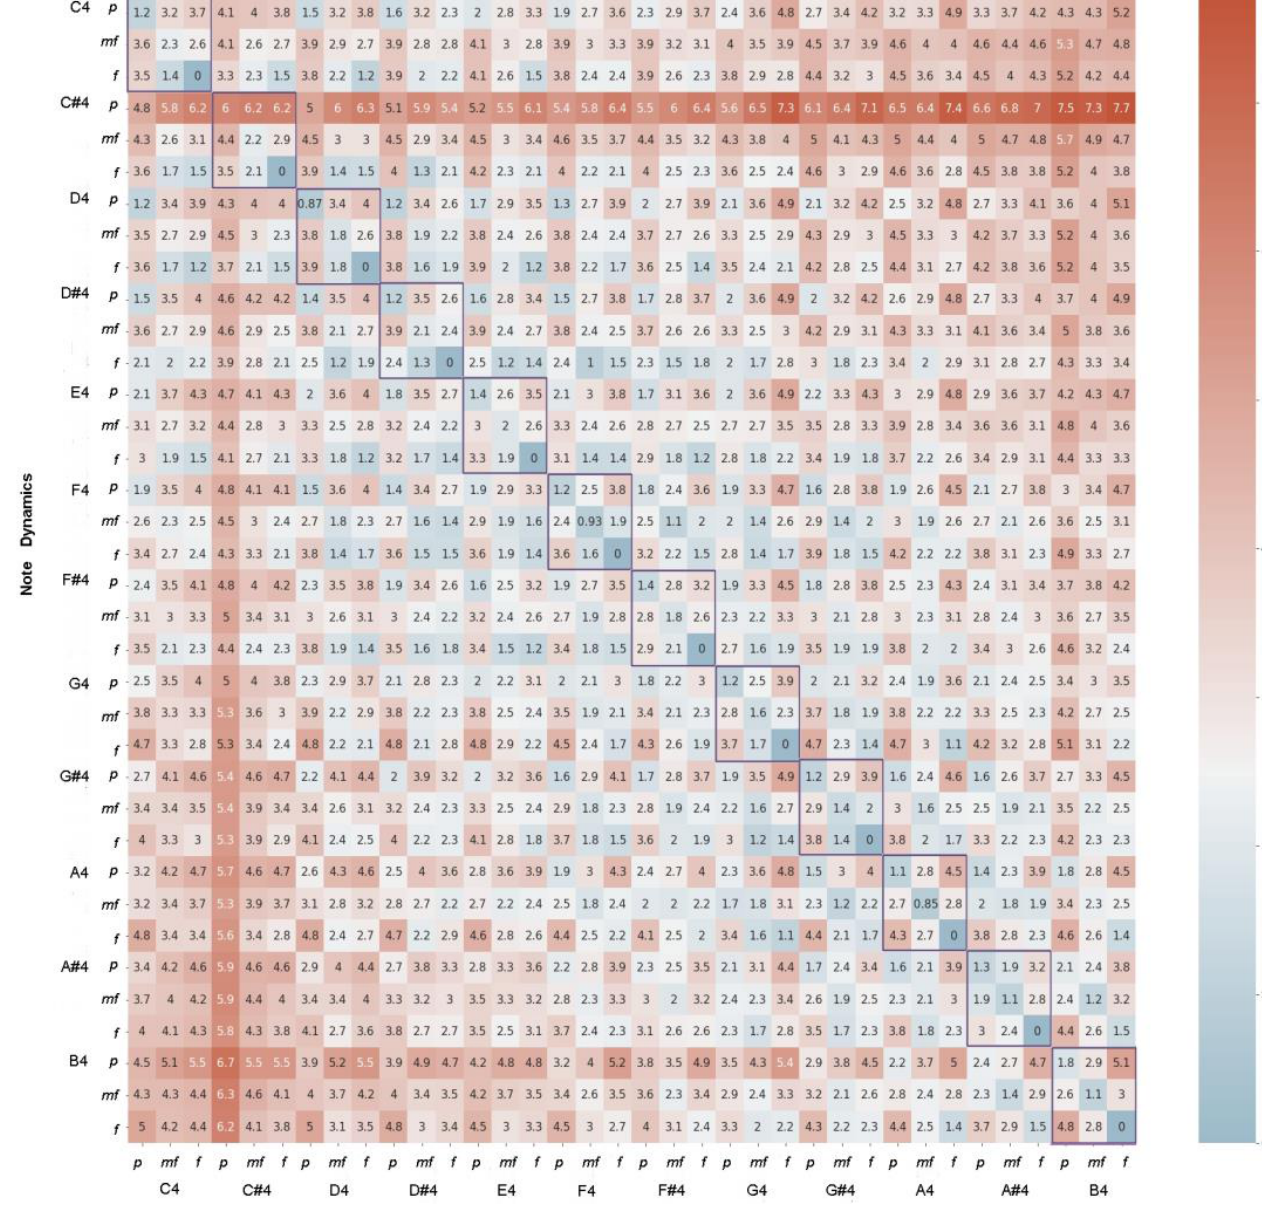
Figure 4. Patterned distance between musical sounds for clarinet (up) and Transverse Flute (down) in several dynamics ( p , mf , f ) for the 4 ta octave, reference sounds in the dataset.